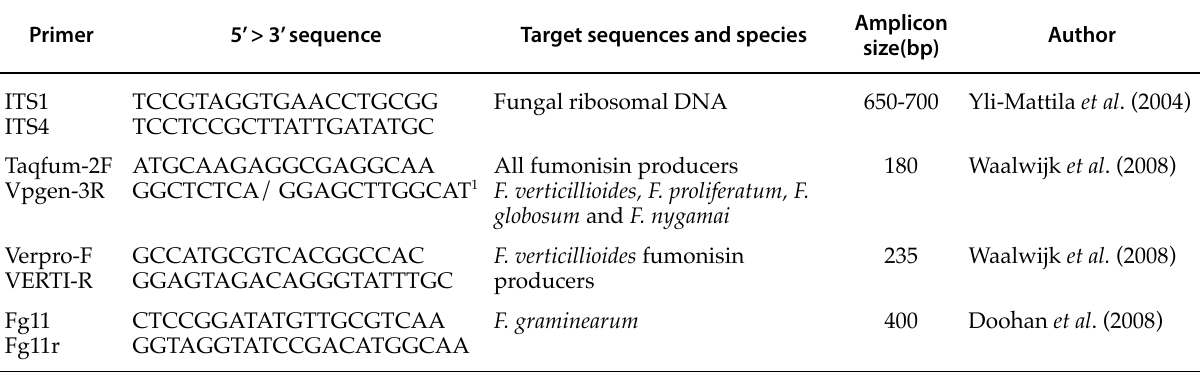
Table 1. Primer sequences used in PCR: ITS1/ITS4 for confirming the quality of DNA, Taqfum-2F/Vpgen-3R for detecting four Fusarium species producing fumonisins, Verpro-F/VERTI-R for detecting fumonisin-producing F. verticillioides,, and Fg11/Fg11r primer pair used for detection of F. graminearum .